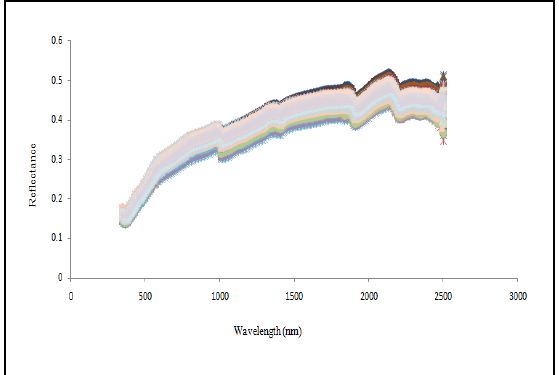
Figure 1. Reflectance spectra (10 nm) of the soil samples